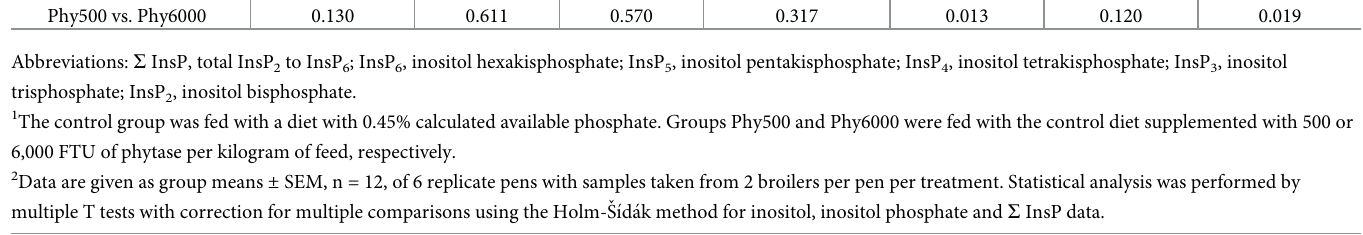
us in this study to measure inositol phosphate levels in combination with existing analytical methods. Kidney tissue inositol phosphates (Table 5) show similar reduction as in digesta with increasing phytase. Ins(1,3,4,5,6)P is the dominant inositol phosphate measured in these tis- 5 sues followed by D-/and or L-Ins(3,4,5,6)P , with InsP over 3-fold higher than InsP in these 4 5 6 samples (Fig 1B). Significant differences were measured between the Control and Phy6000 diets for: InsP (P = 0.023), 27.0 ± 5.4 nmol/g wwt and 9.8 ± 1.5 nmol/g wwt, respectively; 4